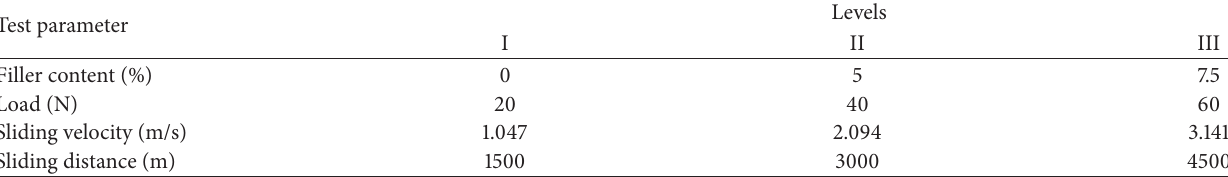
Figure 1: Schematic representation of composite fabrication process. Table 3: Experimental